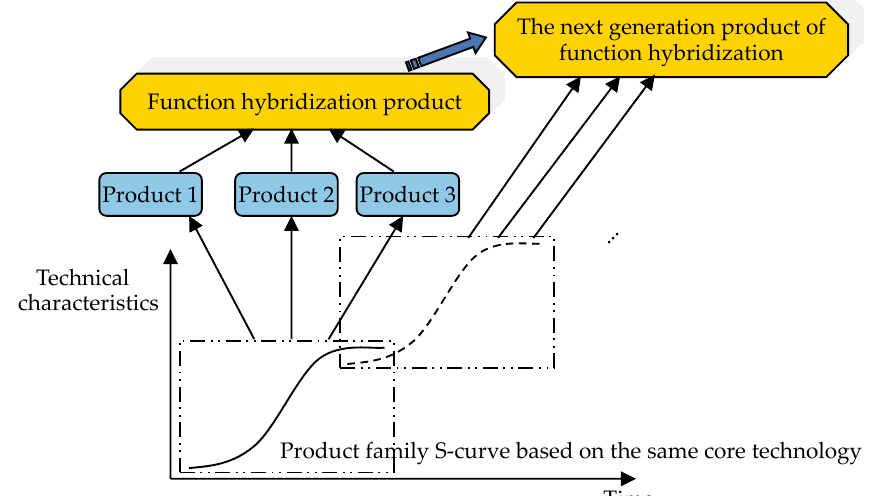
Figure 1. Intraspecific functional hybridization.